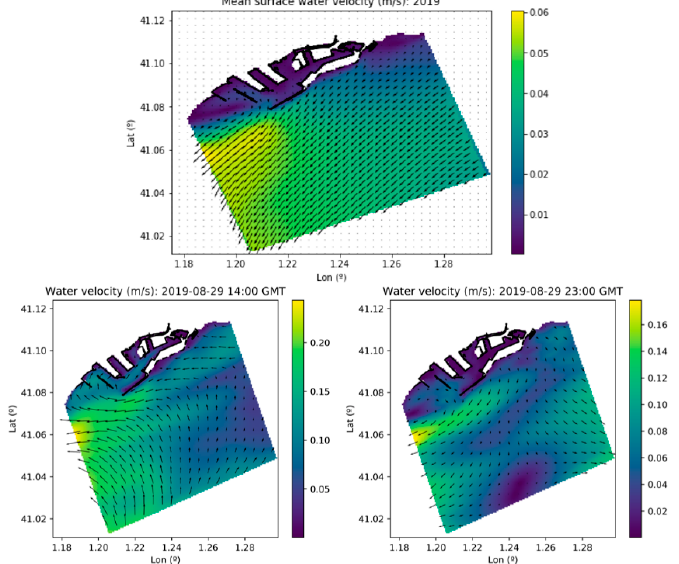
Figure 7. ( upper ) Averaged water current from the Port model during 2019. Water current fields during sea-breeze event: 2019-08-29 14:00 GMT ( lower left ) and 2019-08-29 23:00 ( lower right ). Water current fields were obtained from the SAMOA project.